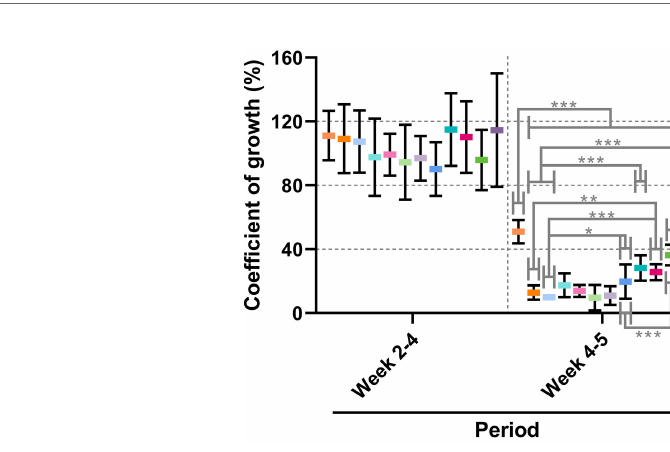
PLGA group has the lowest oocyst output in feces after the challenge, suggesting the strongest anti- E. mitis effect of Em1a- PLGA nanospheres among the tested preparations ( Figure 11 ).